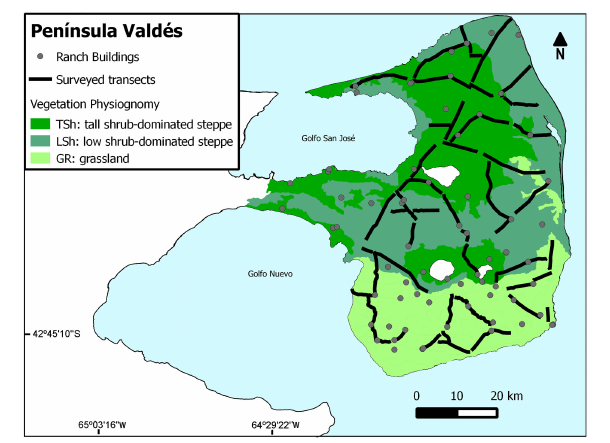
FIGURE 2 | Location of surveyed transects, categories of vegetation physiognomy, and distribution of ranch buildings at one of our study sites (Península